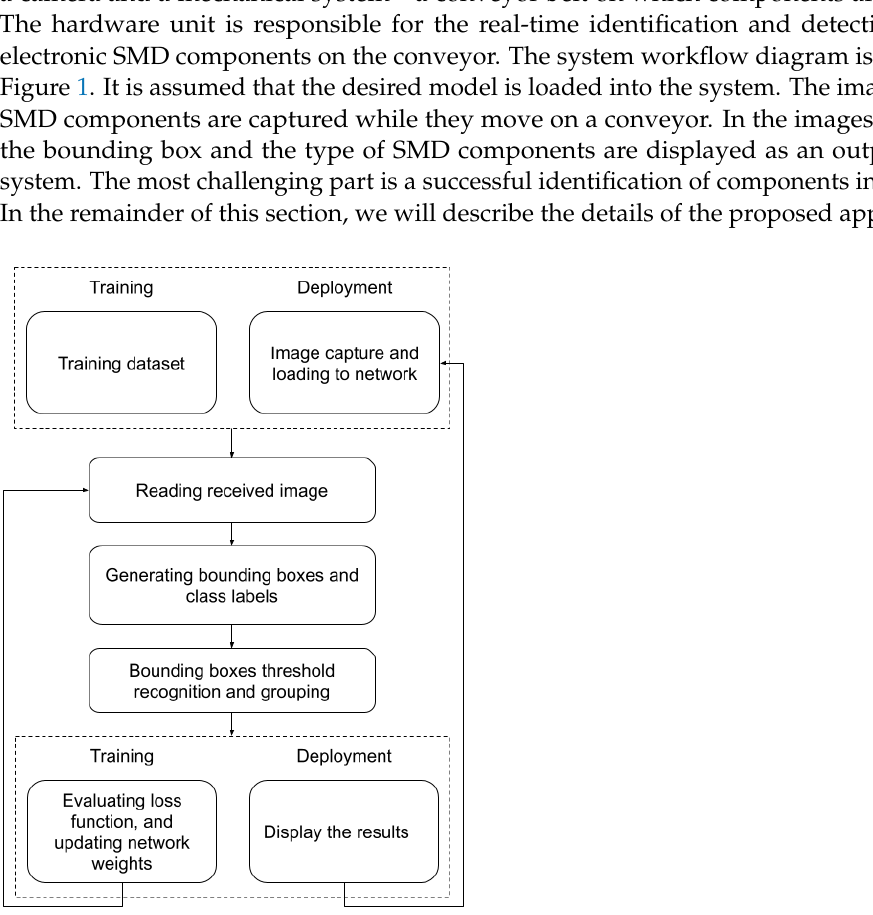
Figure 1. Workflow diagram of the detection system for the deployment and